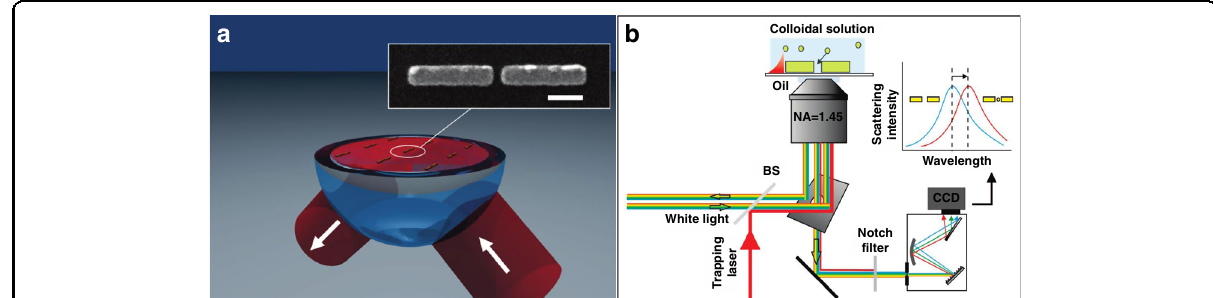
Fig. 5 Principle of structural plasmonic tweezers. a Surface plasmonic trapping con fi guration through the design of nanostructures, scale bar: 200 nm. b Experimental con fi guration. The trapping events can be directly monitored using scattering spectra of the antennas. a Reproduced with permission from ref. 281 , Copyright 2009, American Chemical Society. b Reproduced with permission from ref. 86 , Copyright 2010 American Chemical